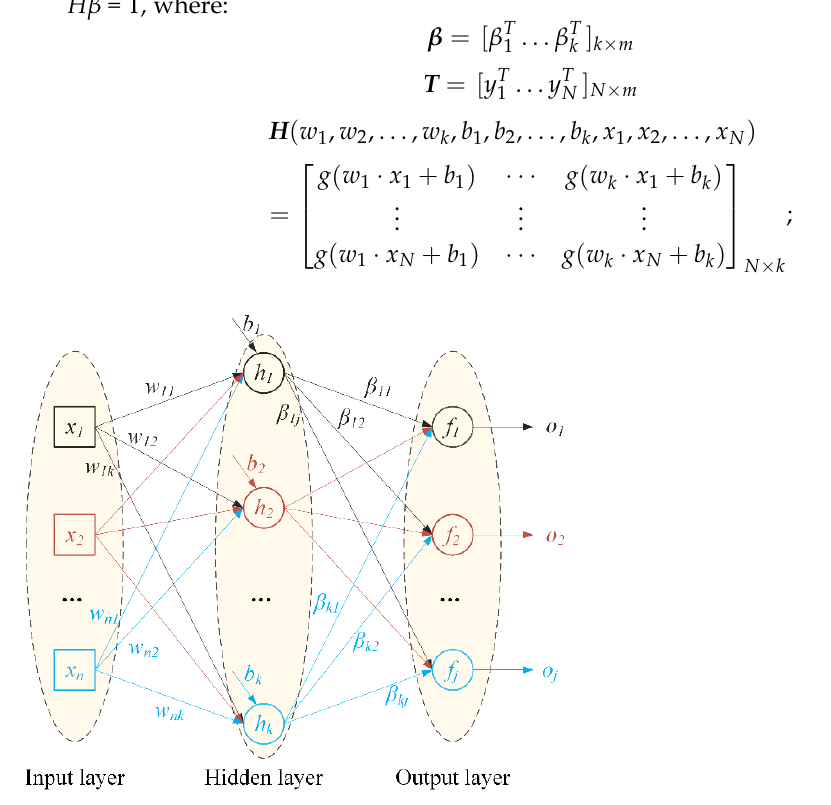
Figure 4. The structure of the SLFN.